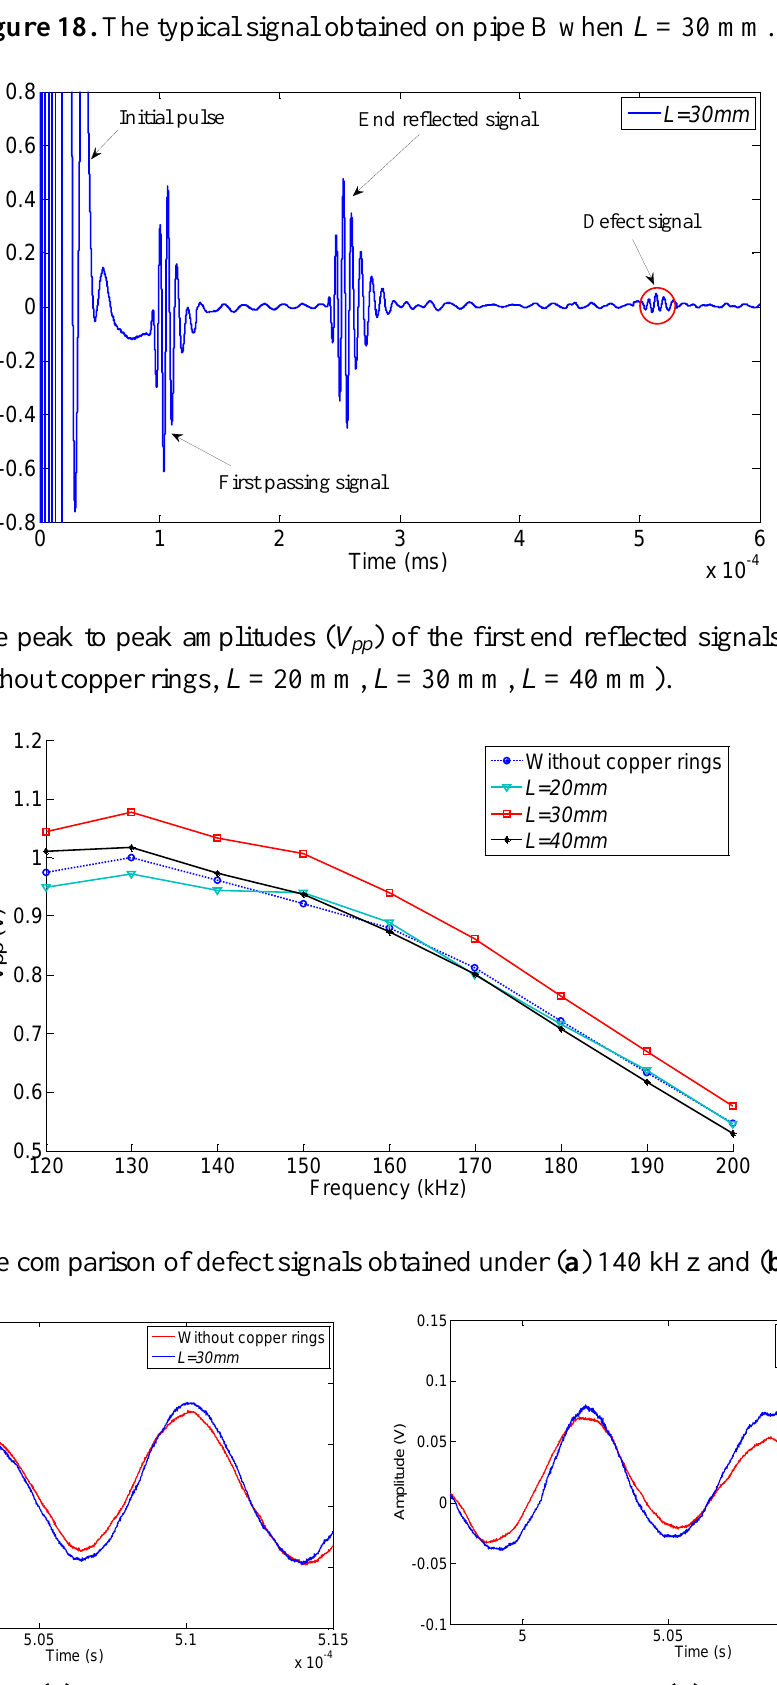
Figure 18. The typical signal obtained on pipe B when L = 30 mm.